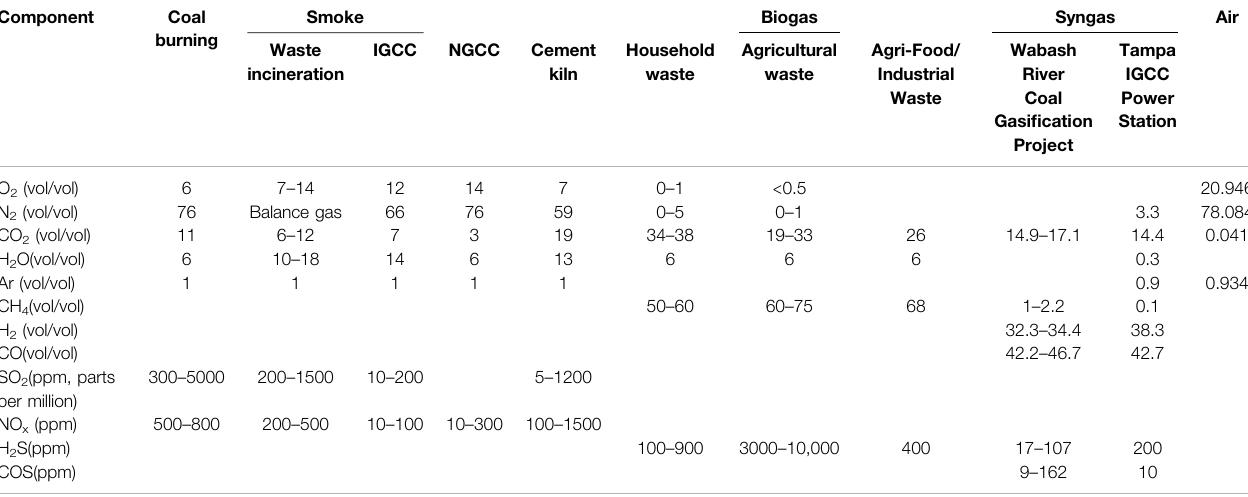
TABLE 2 | Main emission sources of common adsorption carbon capture (Jahandar Lashaki et al., 2019). Component Coal